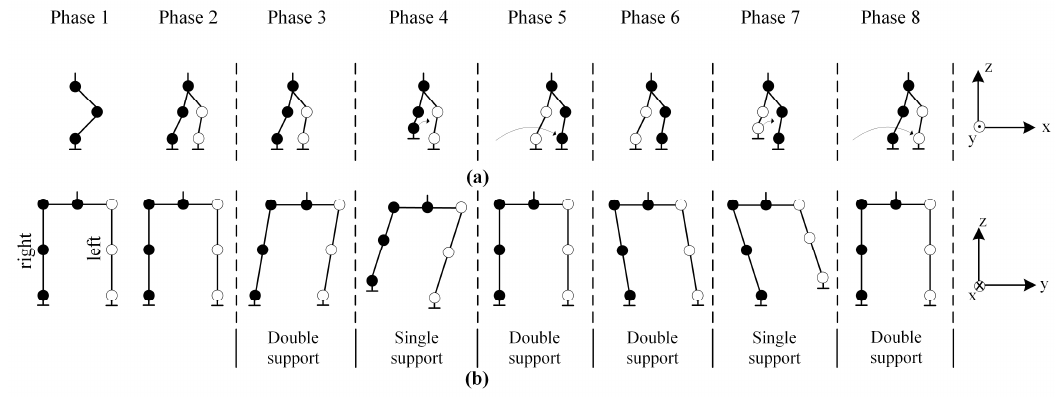
Figure 3. Eight-phase walking process: ( a ) sagittal plane, ( b ) frontal plane. Phase 1: It is the initial phase used to define the robot’s trajectory